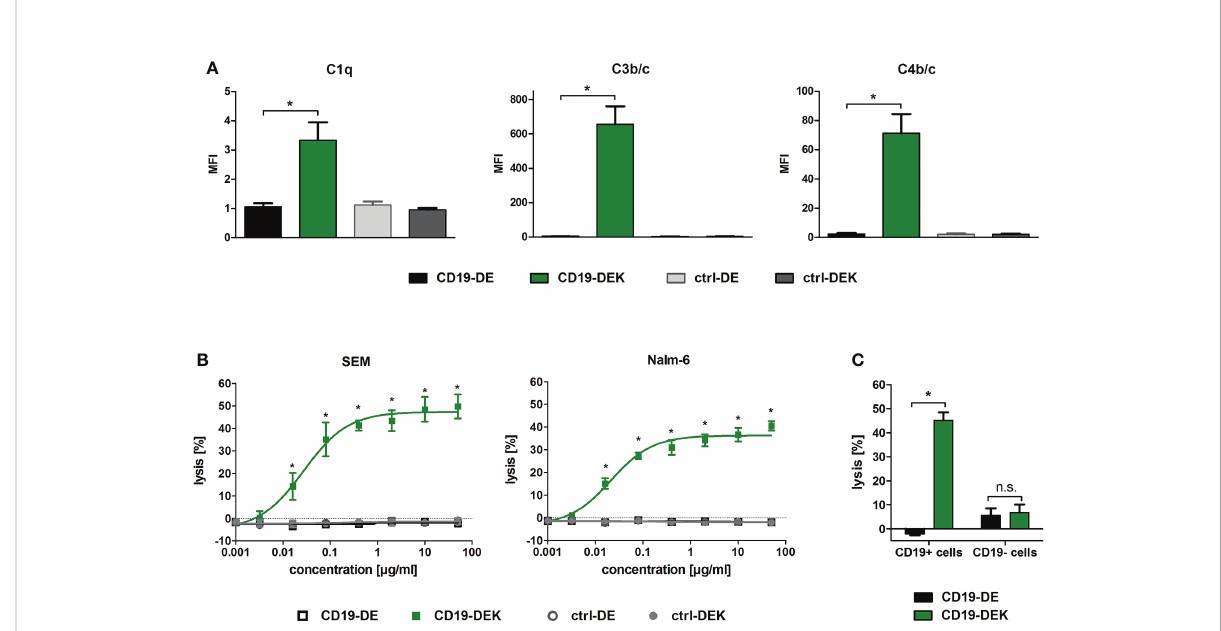
FIGURE 3 CD19-DEK ef fi ciently triggers antibody-dependent complement deposition on target cells and CDC. (A) Antibody-dependent complement deposition on CD19-positive B-ALL cell line SEM was analyzed via fl ow cytometry. Target cells were incubated with the respective antibodies (10 µg/ml) and 25% v/v human serum of healthy donors supplemented with eculizumab. Mean values ± SEM of three independent experiments are presented, * P <0.05% CD19-DEK vs. CD19-DE, One-way ANOVA with Bonferroni post-test. (B) CDC of the tumor cell lines SEM and Nalm-6 was performed in chromium release assays with increasing antibody concentrations and 25% v/v human serum of healthy donors. The tumor cell lysis was tested for CD19-DEK and CD19-DE and was compared to the control antibodies ctrl-DEK and ctrl-DE. Mean values ± SEM of three independent experiments are presented, * P <0.05% CD19-DEK vs. CD19-DE, Two-way ANOVA with Bonferroni post-test. (C) Target antigen speci fi c CDC was tested in chromium release assays with CD19-positive (Nalm-6, SEM) and CD19-negative (MOLT-16, CEM) tumor cells at an antibody concentration of 50 µg/ml and 25% v/v human serum of healthy donors. The tumor cell lysis mediated by CD19-DEK was compared to CD19-DE. Mean values ± SEM of three independent experiments are presented, * P <0.05%, ns, not signi fi cant. CD19-DEK vs. CD19-DE, two-tailed t-Test with Mann-Whitney